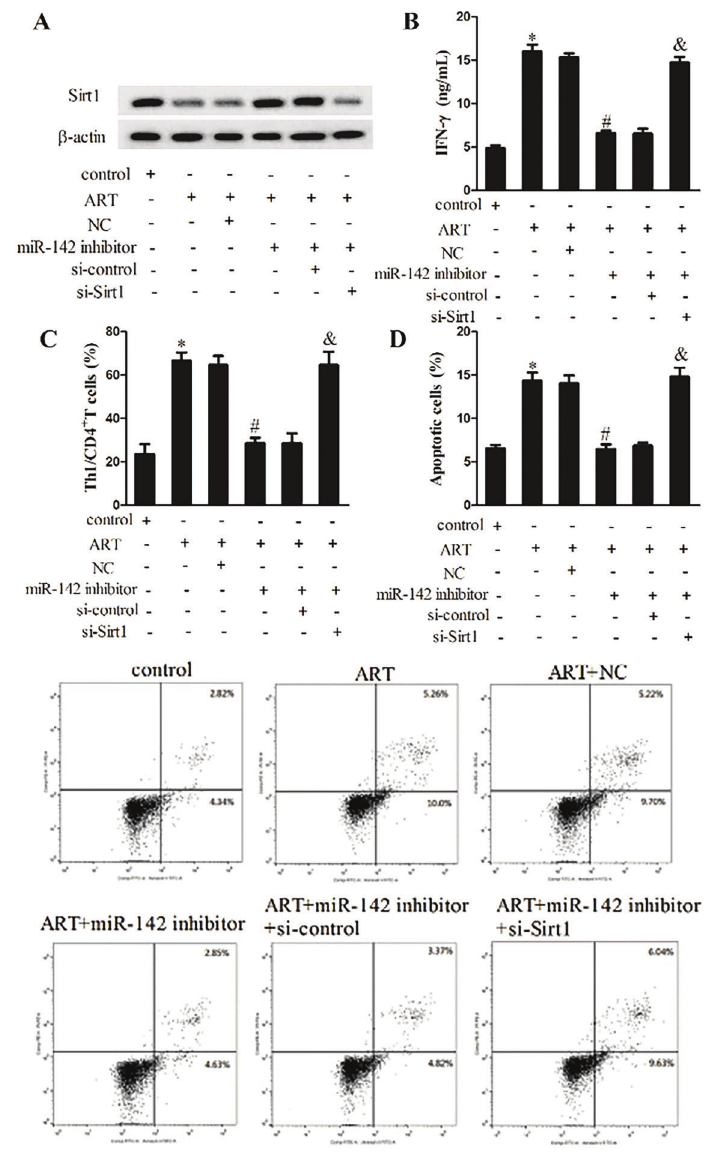
Figure 4. Artesunate (ART, 50 m g/mL) enhanced the pro-apoptotic effects of Th1 cells on ovarian cancer via miR-142/Sirt1 pathway. A , Expression of Sirt1 protein was determined using western blot. B , Interferon (IFN)- g level in culture supernatant was evaluated by ELISA. C , The percentage of Th1/CD4 + T cells was analyzed using fl ow cytometry. D , After co-cultured with the differentiation-induced and artesunate-treated CD4 + T cells, ID8 cells apoptosis was measured using fl ow cytometry. NC: negative control. Data are reported as means ± SD. *P o 0.05 compared to control; # P o 0.05 compared to ART + NC; & P o 0.05 compared to ART + miR-142 inhibitor + si-control